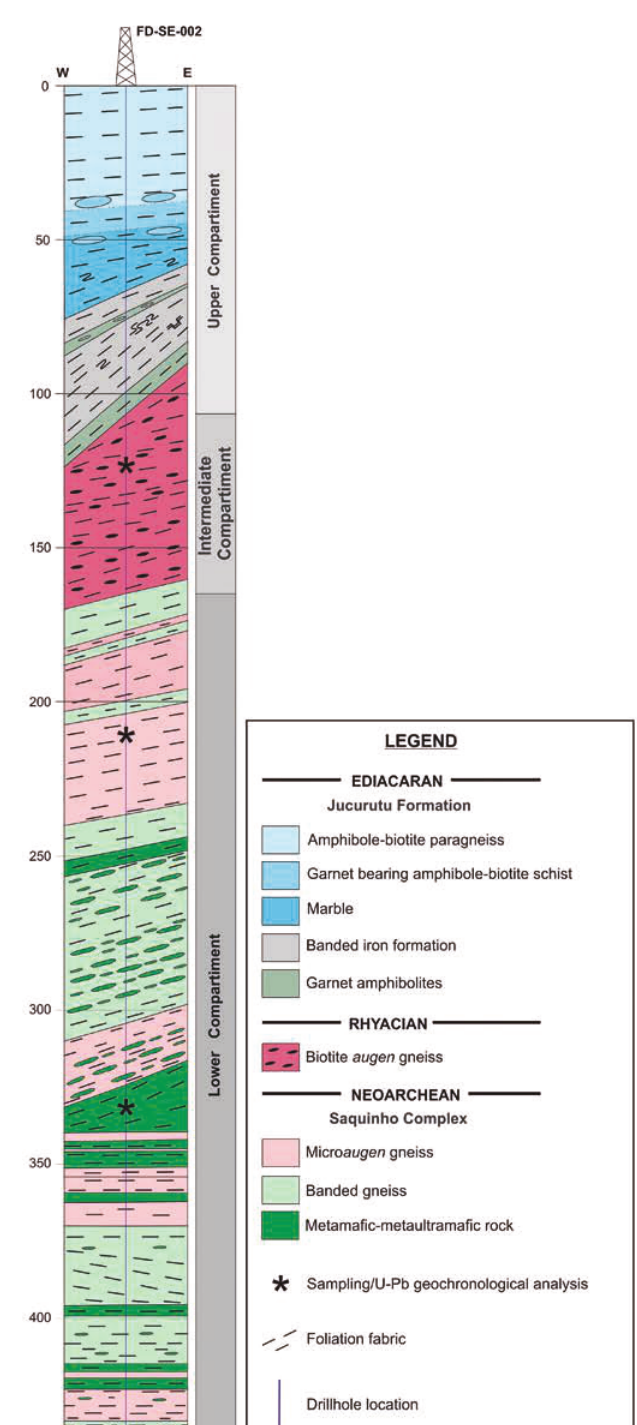
Figure 5 - Cross-section of the drill hole FD-SE-002 performed near the Saquinho iron mine, highlighting the three geological compartments, as well as the sampling sites for the U-Pb geochronological